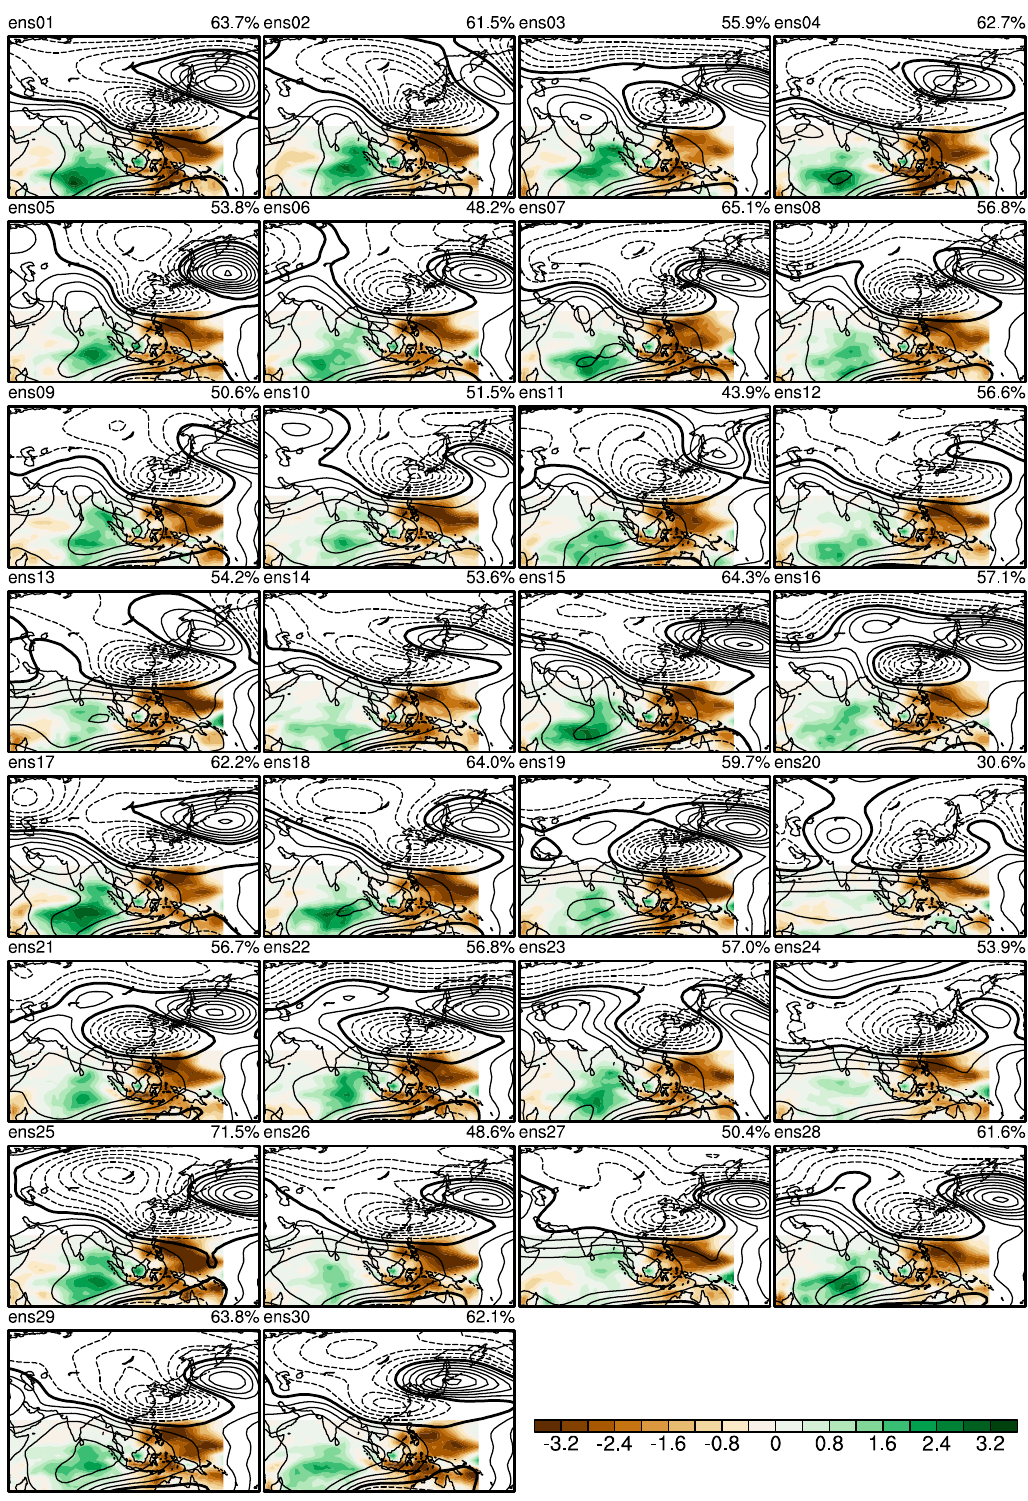
Figure 2. The first (second for member 20) SVD mode between rainfall (shading; unit of mm/day; 20° S–20° N, 40°–160° E) and Z200 (contours; int: 5 gpm; 20° S–70° N, 40°–180°E) in each of the 30 ensemble members of ECHAM5. The number above the top-right corner of each panel indicates the percentage of covariance explained by the SVD.